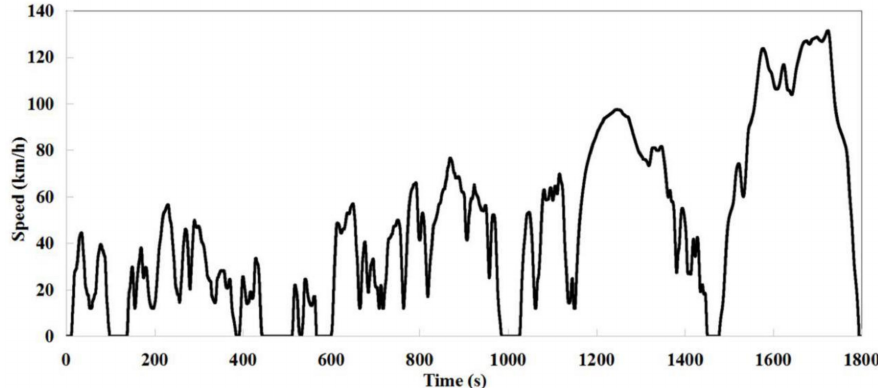
Figure 1. Curve of the worldwide light-duty test cycle